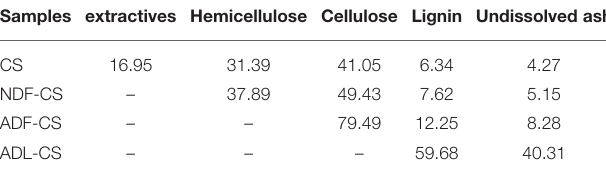
TABLE 2 | Component of corn stover and its detergent fibers